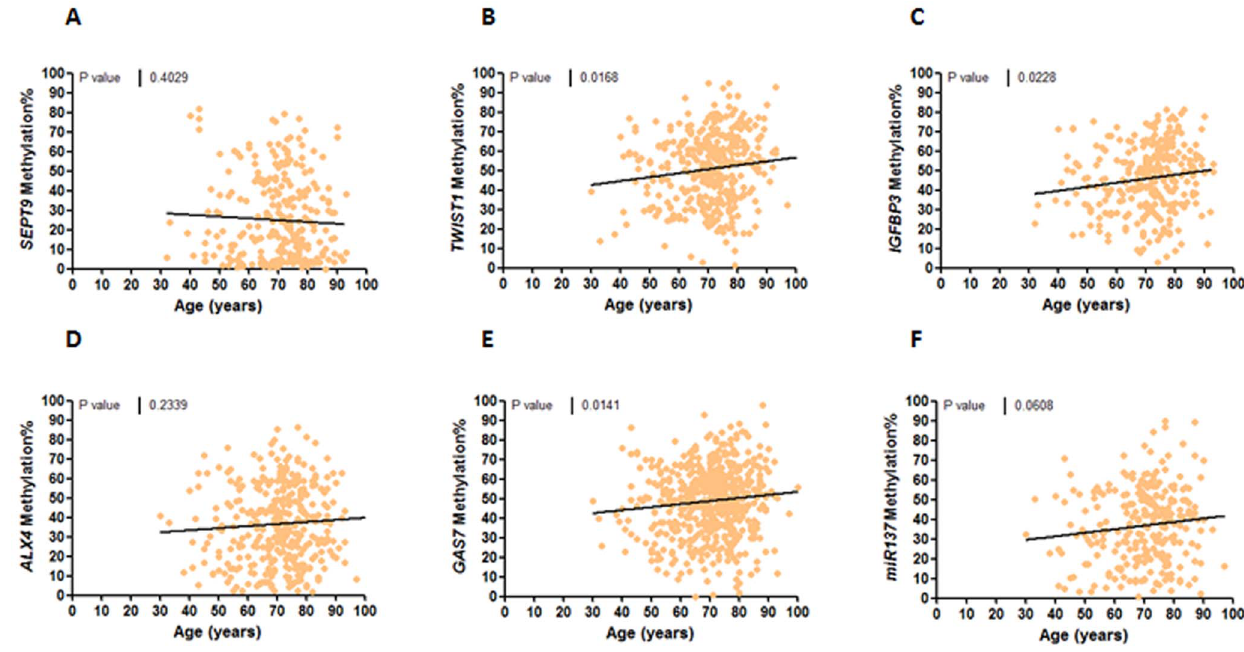
Figure 3. Correlation between primary tumor methylation and age of the crc patients. linear regression analysis comparing tumor methylation of sept9 (a), twist1 (b), igfbp3 (c), alx4 (d), gas7 (e) and mir137 (f) vs age of crc patients (years).